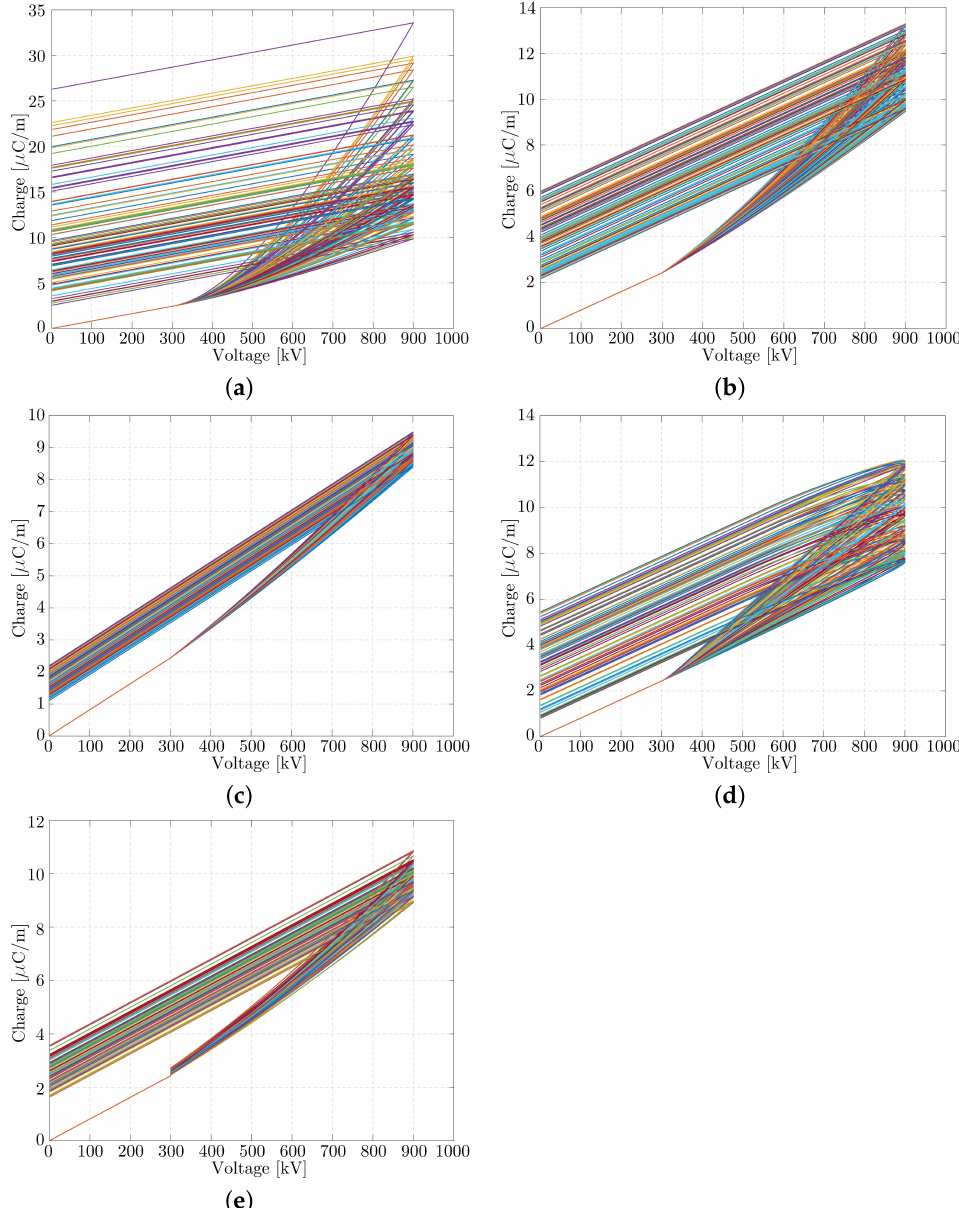
Figure 9. Charge-voltage loops displaying the sensitivity of empirical models to the variation of the input parameters. ( a ) Inoue, ( b ) Gary, ( c ) Sivaev and Podporkin, ( d ) Suliciu, ( e ) Cigré. Sensitivity curves computed by the Cigré model with respect to C (cid:48) in Figure 9e. Considering the values of K in [66] corresponding to the diameter of the reference conductor, q - v loops are displayed for K ∈